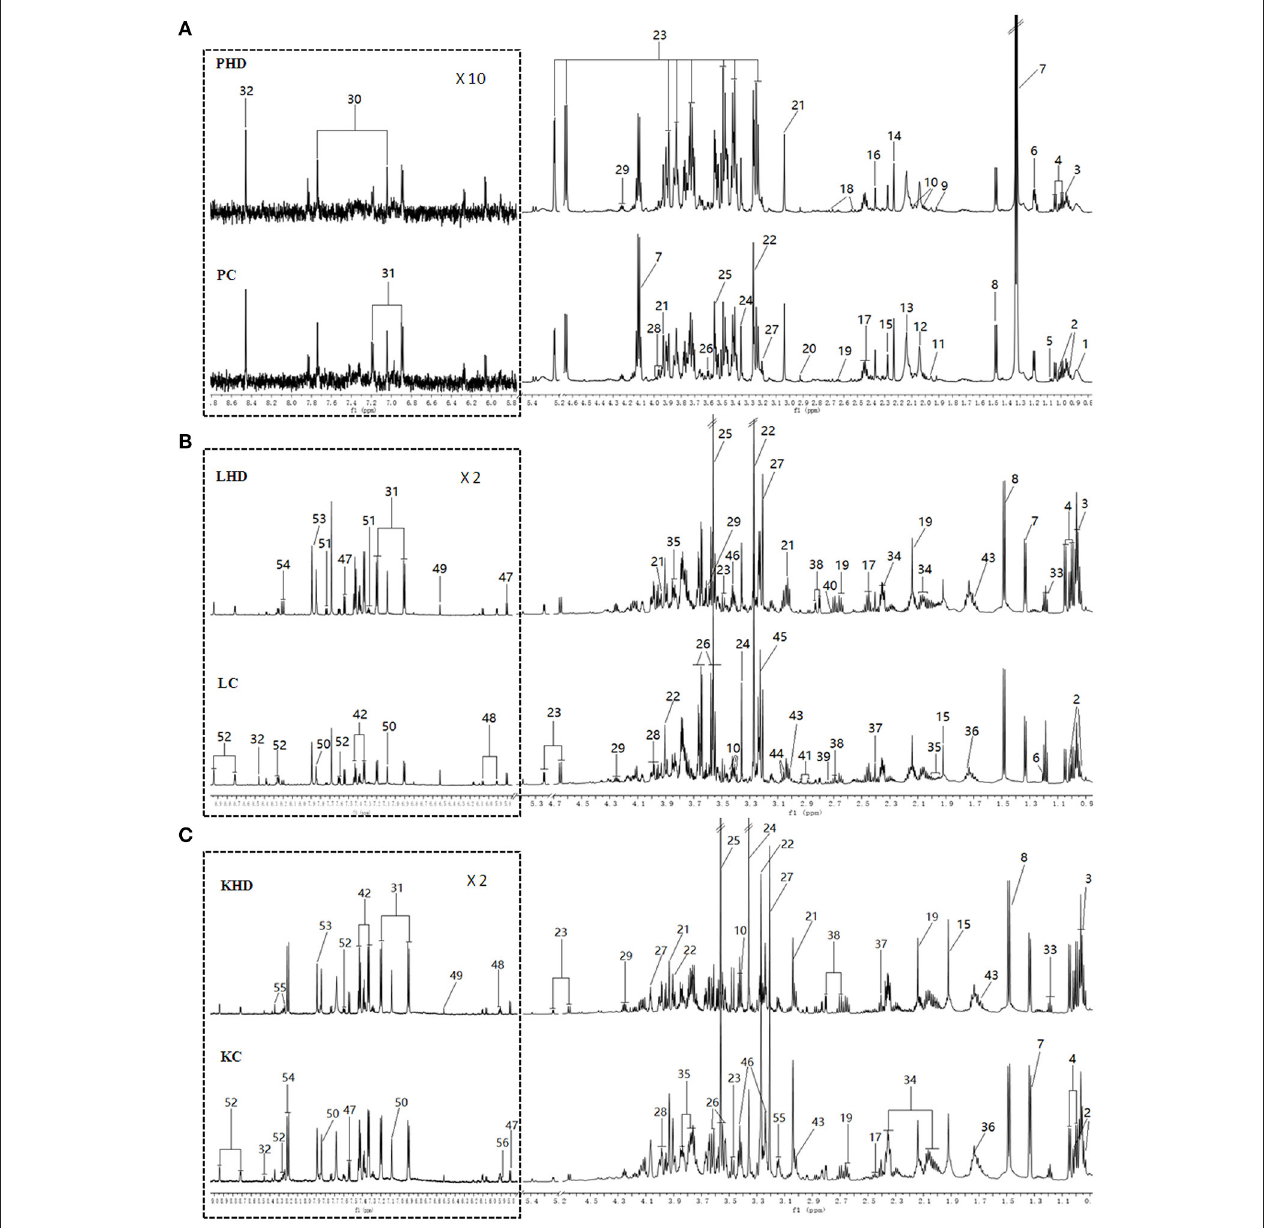
FIGURE 2 | Typical 600 MHz 1 H NMR spectra from plasma (A) , aqueous liver (B) and kidney (C) extracts. (PHD, LHD, and KHD) plasma, liver extract, and kidney extract from a rat dosed with high levels of RMP; (PC, LC, and KC) plasma, liver extract, and kidney extract from a control rat. The aromatic regions of plasma spectra are magnified 10 times compared to those of corresponding aliphatic regions. The aromatic regions of kidney and liver spectra are magnified 2 times compared to the aliphatic regions. Distinguished metabolites: 1, LDL; 2, isoleucine; 3, leucine; 4, valine; 5, isobutyrate; 6, 3-Hydroxybutyrate; 7, lactate; 8, alanine; 9, acetate; 10, proline; 11, CH2CH2C = C lipid; 12, NAC1; 13, NAC2; 14, acetone; 15, acetoacetate; 16, pyruvate; 17, glutamine; 18, citrate; 19, methionine; 20, N,N-dimethylglycine; 21, creatine; 22, betaine; 23, glucose; 24, glycerophosphoylcholine; 25, glycine; 26,glycerol; 27,choline; 28, serine; 29, threonine; 30, methylhistidine; 31,tyrosine; 32, formate; 33, ethanol; 34, glutamate; 35, homoserine; 36, arginine; 37, succinate; 38, aspartate; 39, sarcosine; 40, dimethylamine; 41, asparagine; 42, phenylalanine; 43, lysine; 44, ornithine; 45, phosphocholine; 46, taurine; 47, uracil; 48, cytidine; 49, fumarate; 50, histidine; 51, tryptophan; 52, niacinamide; 53, xanthine; 54, hypoxanthine; 55, inosine; 56, uridine; 57, urea.